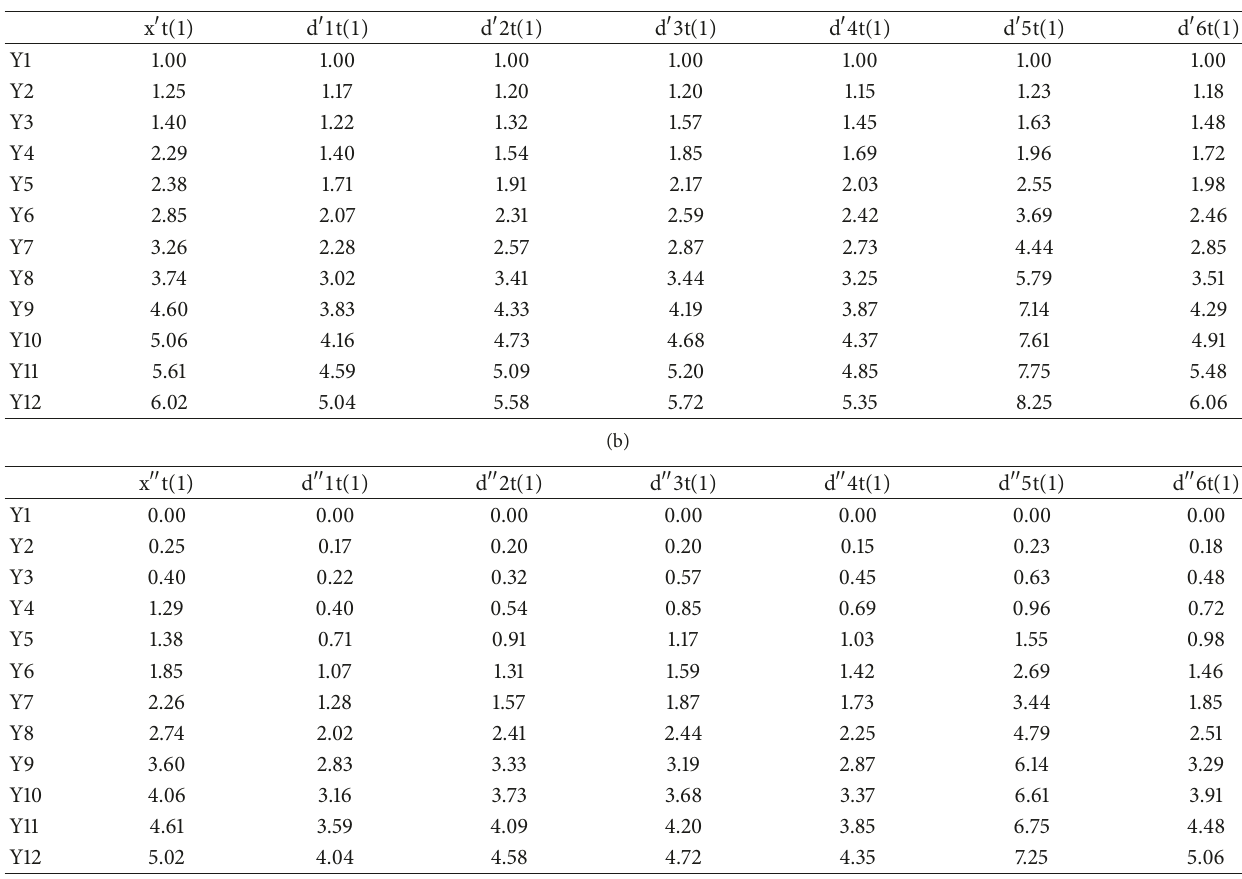
Table 8: The starting-point annihilating values for Xiamen Port’s cargo throughput and its dry ports’ regional GDP.